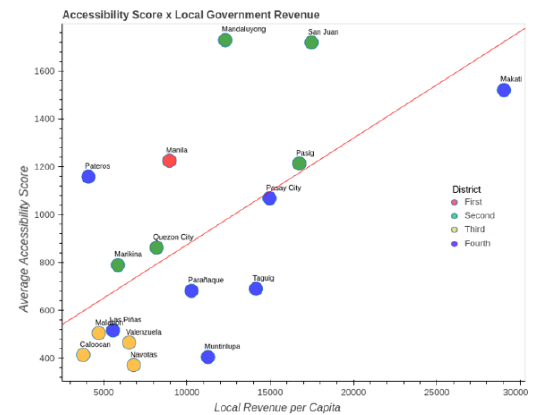
Figure 6 : Revenue per capita and Accessibility in the National Capital Region